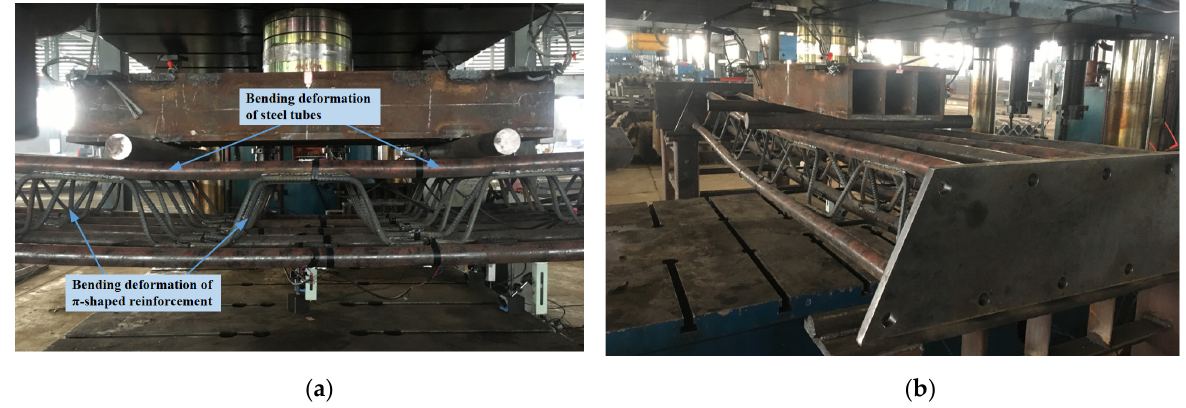
Figure 12. Failure mode of the jointless component. ( a ) Elevation view and ( b ) axonometric drawing.